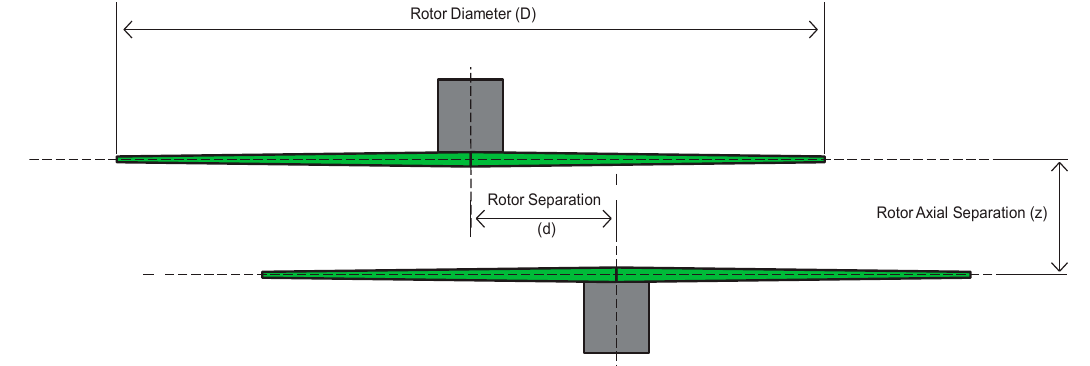
Figure 2. Propulsion system configuration diagram.